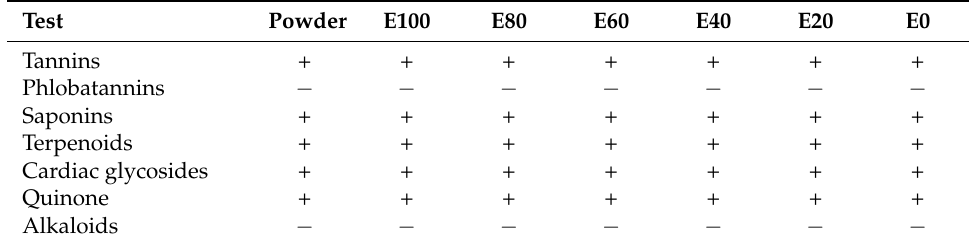
Table 2. Phytochemical groups of D. sanderiana leaves extracts and powder.